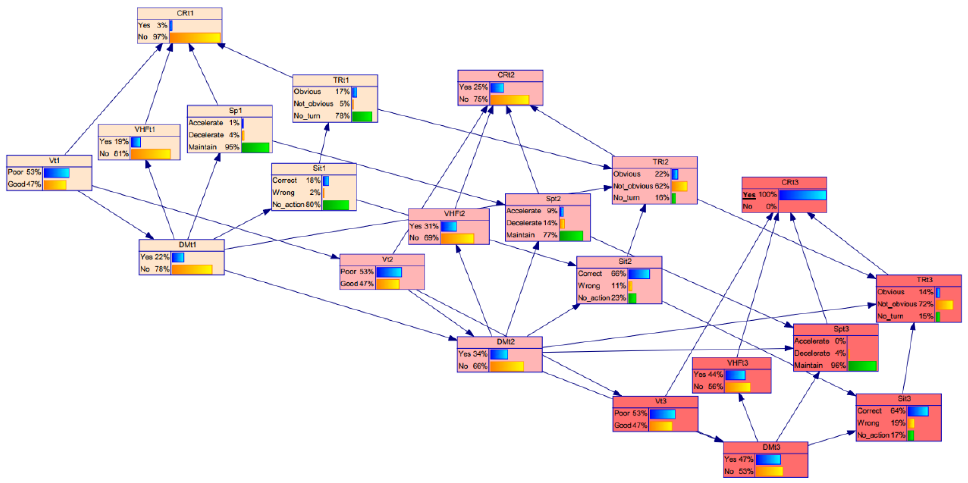
Figure 14. Reverse reasoning for the DBN model.